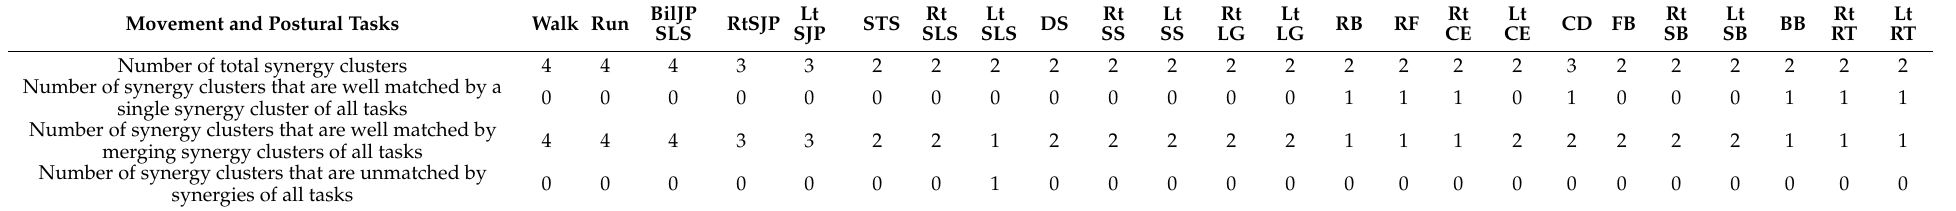
Table 4. The relationship between synergy clusters of each task and synergy clusters of all